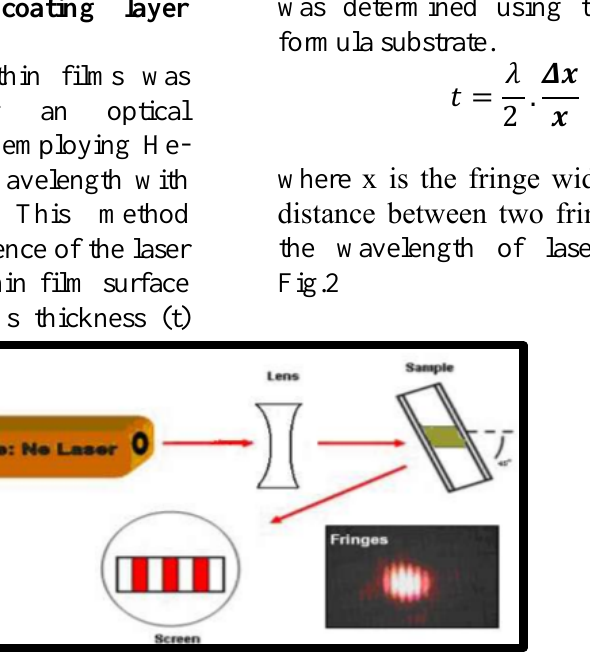
Fig. 2: The schematic diagram of the film